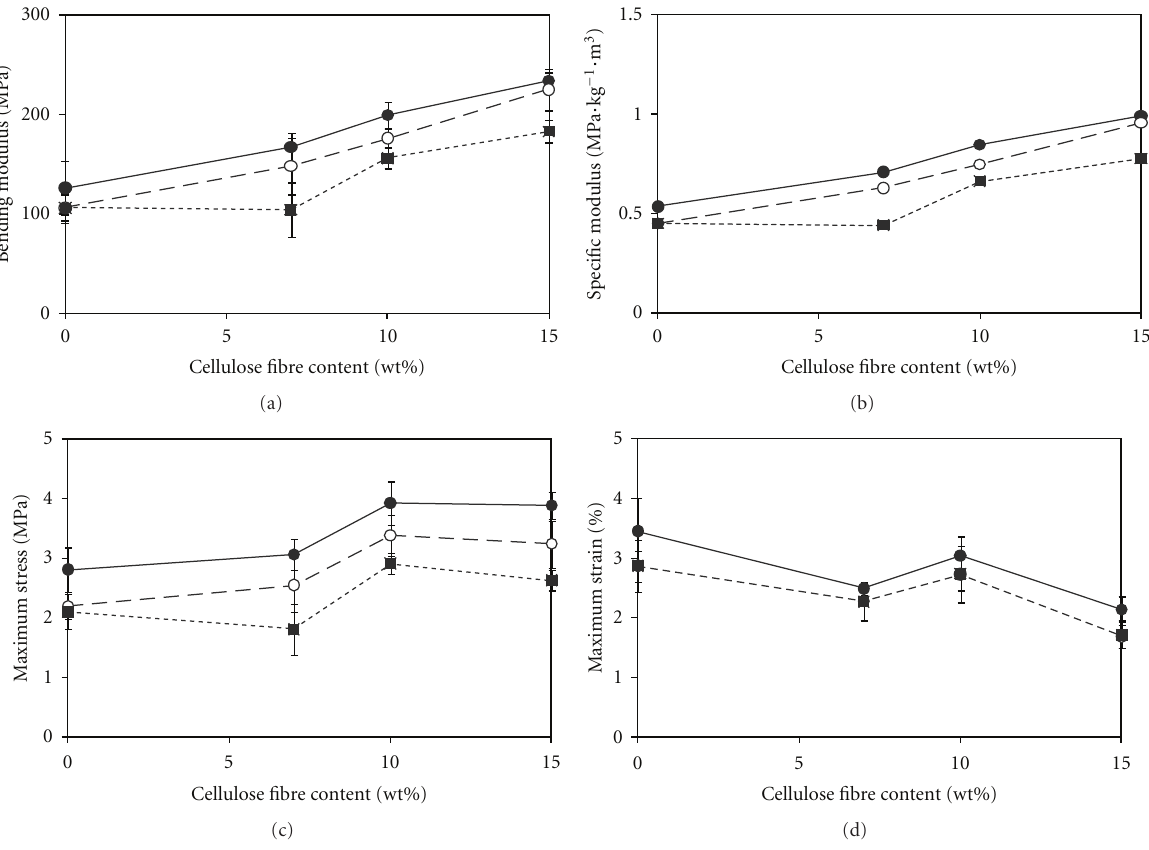
Figure 3: Mechanical properties of starch and biocomposites foams as a function of the cellulose fibre weight content and the relative humidity: (cid:2) 33 RH%, (cid:3) 56 RH%, (cid:2) 75 RH%, (a) bending modulus, (b) bending modulus/density ratio, (c) maximum stress; (d) maximum strain. Table 7: Size (mean diameter in number d n , mean diameter in weight d w , wall thickness of cells e , polydispersity index PDI, and sphericity I